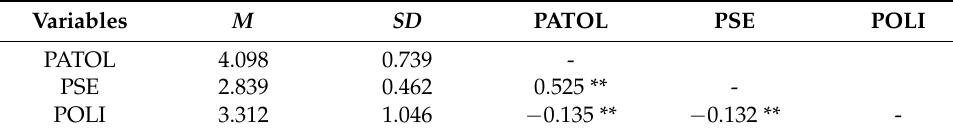
Table 2. Descriptive statistics of model variables and correlations among model